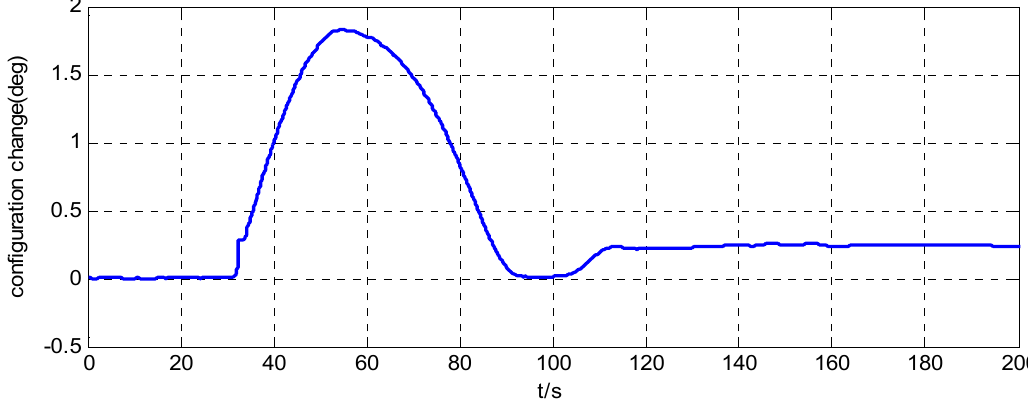
Figure 7. Angular velocity around the z-axis of the simulator when